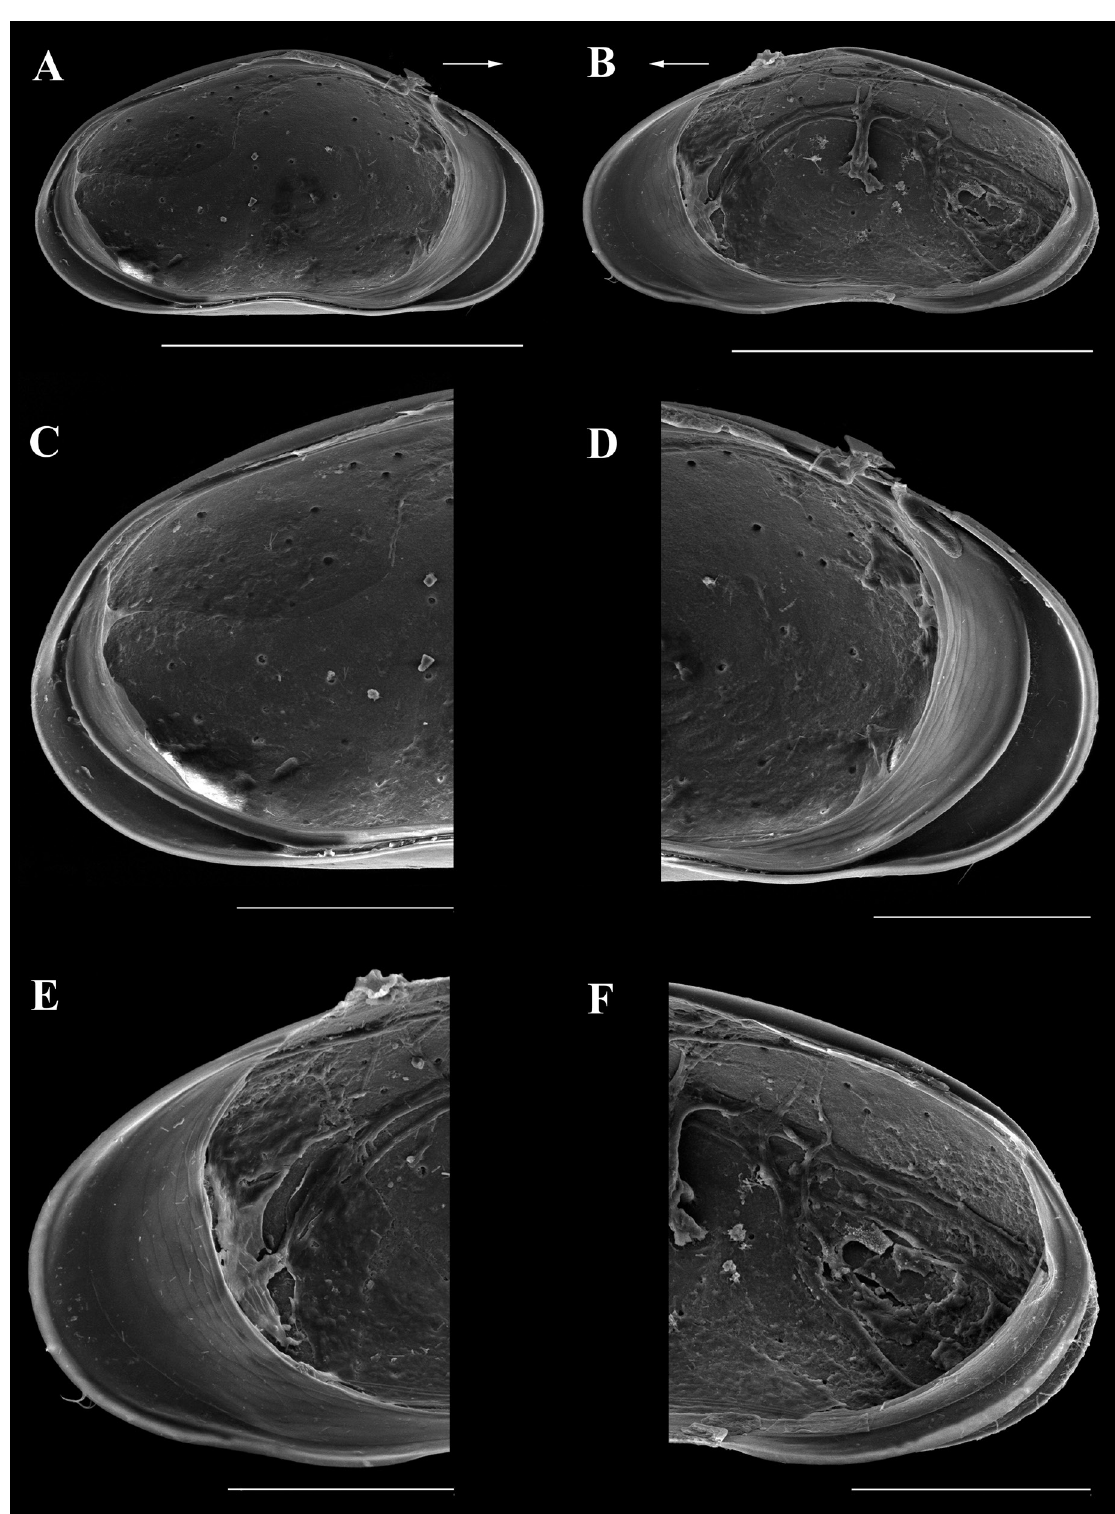
Fig. 2. Brasilodopsis baiabonita gen. et sp. nov. from Bonito, State of Mato Grosso do Sul, ♂. A . LVi (MZUSP 41825). B . RVi (MZUSP 41825). C . LVi, detail of posterior part (MZUSP 41825). D . LVi, detail of anterior part (MZUSP 41825). E . RVi, detail of anterior part (MZUSP 41825). F . RVi, detail of posterior part (MZUSP 41825). Scale bars: A–B = 300 µm; C–F = 100